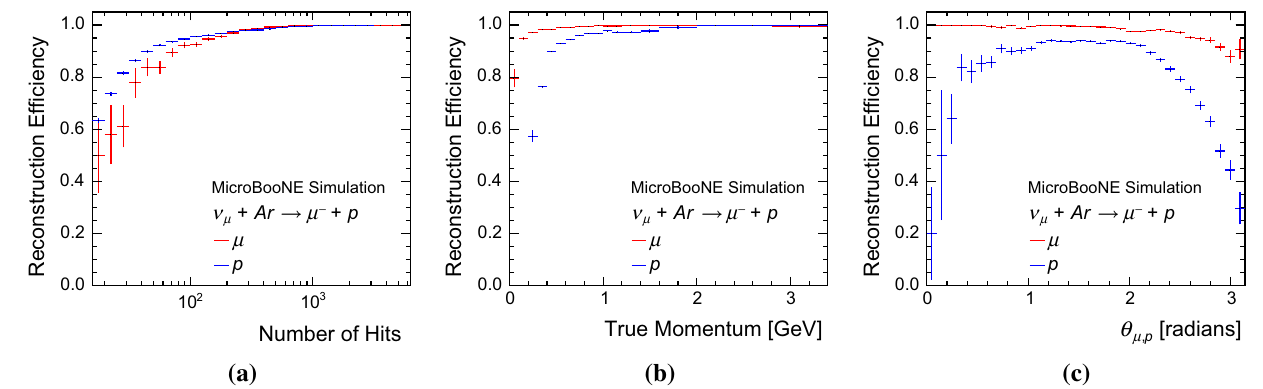
Fig. 12 Reconstruction efficiencies for the target muon and proton in simulated BNB CC ν μ quasi-elastic interactions, a as a function of the numbers of true hits, b as a function of true momenta and c as a function of the true opening angle between the muon and proton. The error bars show binomial uncertainties